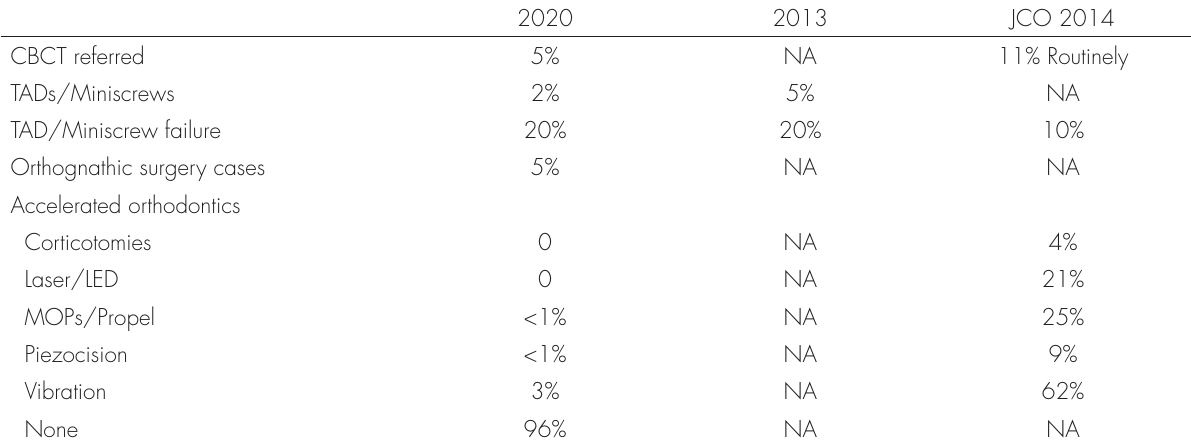
Table VII. Adjunctive